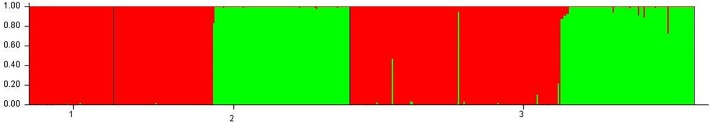
Assignment of 473 castor accessions into two clusters (red and green) with STRUCTURE 2.3.4.